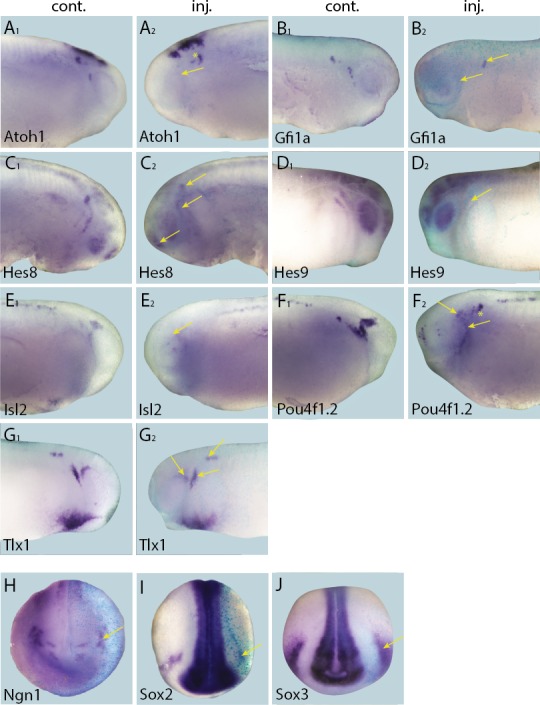
Effects of Six1 knockdown on target genes.Tail bud stage (A–G) and neural plate stage (H–J) embryos after unilateral injection of Six1-MO1+2. In each case, lacZ was co-injected as a lineage tracer and panels A1–G1 show the control (un-injected) side and A2–G2 show the injected side. The injected side is positioned to the right in H–J, as marked by blue lacZ staining (lacZ staining out of frame in some specimens). Arrows mark reductions in marker gene expression in placodal derivatives, and asterisks indicate increased expression.